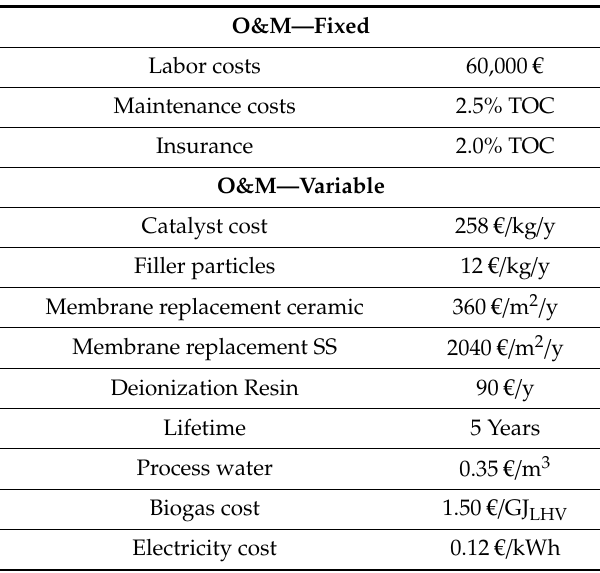
Table 10. Assumptions to calculate the O&M costs [48,52,56].